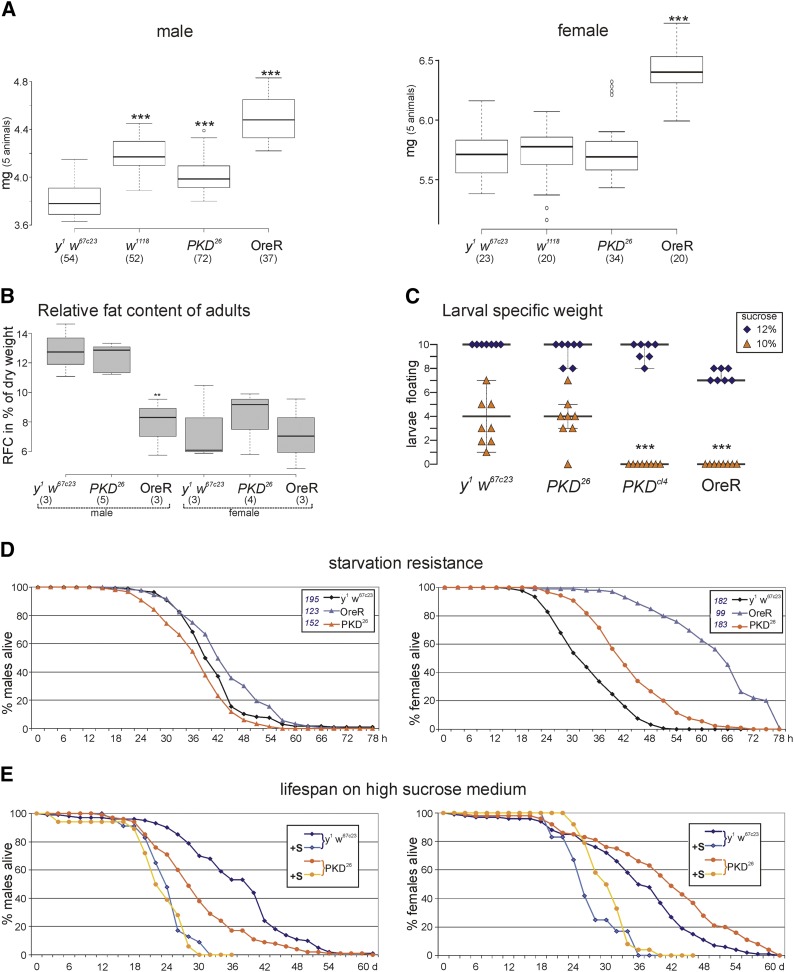
Influence of PKD on body weight and starvation resistance. (A) BoxPlot representation of the fresh weight of animals of the given genotype weighed in batches of five given in mg. The left panel shows the weight range of males, the right panel that of females. (B) The relative fat content of male and female flies of the given genotype was determined on 25-30 animals per experiment relative to the dry weight. PKD26 mutants are not different from y1 w67c23 control, whereas OreR males have a significantly larger body weight, and hence, a relatively low fat content. BoxPlots in (A) and (B) depict medians as Center lines; box limits indicate the 25th and 75th percentiles; whiskers extend 1.5 times the interquartile range; outliers are represented by dots. Sample points are given for each genotype in parentheses. Statistical analysis was performed with a two-tailed ANOVA test relative to y1 w67c23 using Dunnet’s approach with ***, P < 0.001 and **, P < 0.01. (C) Larval specific weight was determined in a floating assay with sucrose of different density. Number of floating larvae is indicated for 12% sucrose (blue, 7 experiments with 10 larvae each) and 10% sucrose (orange, 8 experiments with 10 larvae each). At 8% sucrose, all larvae sank (70 animals tested per genotype). Note that PKD26 resembles y1 w67c23 control, and PKDcl4 the OreR control. (D) Sensitivity to starvation stress was measured as survival of male and female flies on wet filter paper over time; dead flies were counted regularly. Whereas males of different genotype were similar, female OreR flies were highly resistant and female y1 w67c23 very sensitive toward starvation (4-6 experiments each; the total number of tested animals is given in the legend for each genotype). (E) Lifespan was determined on medium with normal and high sucrose content (+s). High sucrose medium shortened life span of PKD26 mutants as well as y1 w67c23 control irrespective of sex to similar values.